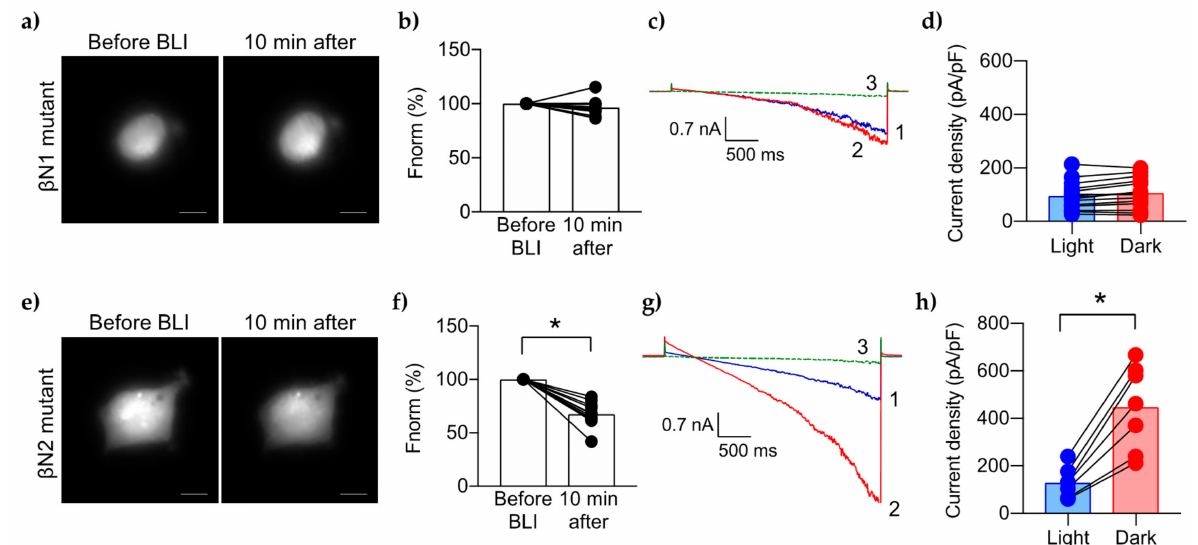
Figure 4. Effects of PIP2 depletion on mutant β -ENaC. Representative micrographs showing the CoroNa Green uptake in HEK 293 cells transfected with mutant β N1-ENaC ( a ) or mutant β N2-ENaC ( e ). The graphs in ( b , f ) summarize changes in the mean [Na + ] i as determined by CoroNa Green fluorescence levels (n = 11 per group). Representative current traces of the β N1 mutant ( c ), or the β N2 mutant ( g ), under BLI (1, blue trace), then dark (2, red trace), then 10 µ M amiloride (3, green trace). Summary graphs of the mean current density for the β N1 mutant (n = 14) ( d ), or the β N2 mutant (n = 7) ( h ), at − 100 mV under low PIP2 levels (“Light”, blue bar and blue circles) vs. maximum PIP2 levels (“Dark”, red bar and red circles). For each graph, the line drawn between 2 circles represents an independent cell under different PIP2 levels. *, p < 0.0001 determined by paired t